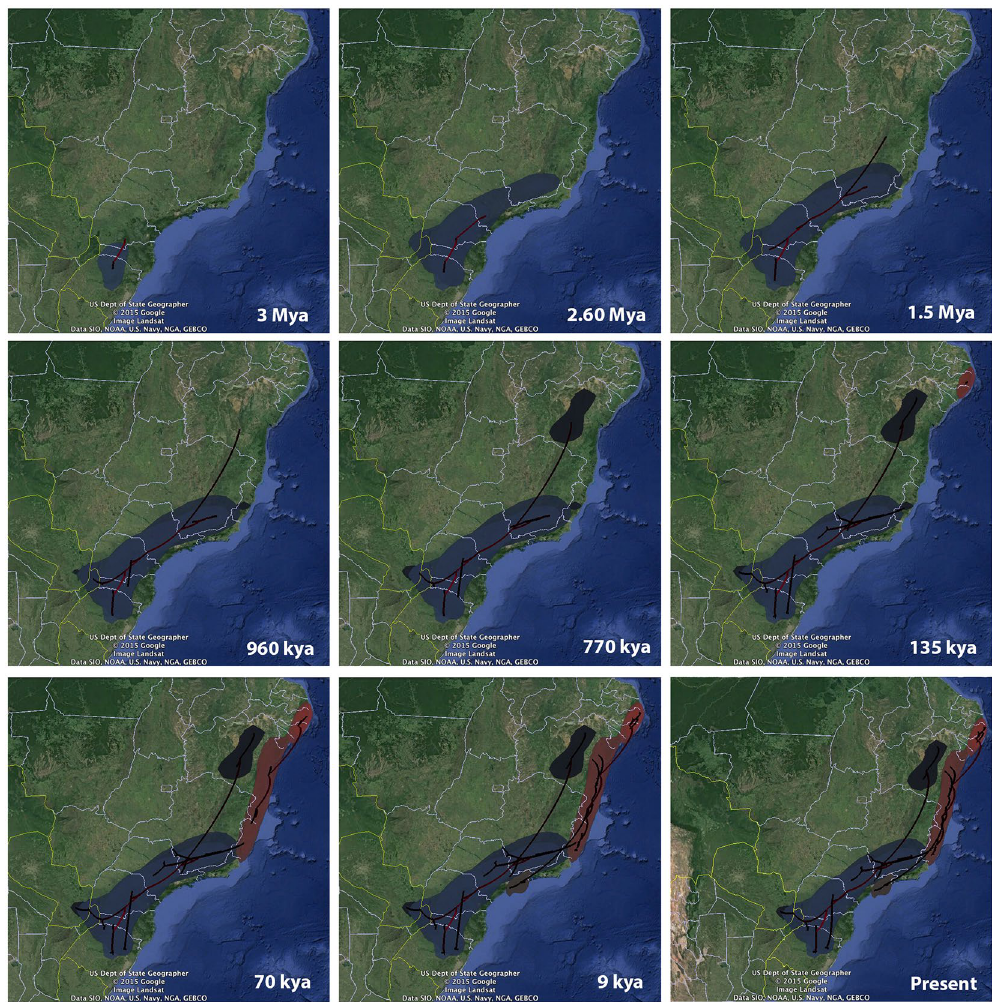
Figure 5. Bayesian reconstruction of the spatio-temporal dispersal of S. cyanea (blue shading) and S . aff. septentrionalis (red shading). Reconstructions are based on the maximum clade credibility tree estimated with a time-heterogeneous Relaxed Random Walk (RRW) model. Shading represents 80% HPD uncertainty in the location of ancestral branches with lighter and darker shades representing older and younger dispersal events, respectively. The map was generated using the software Google Earth 7.1.5.1557 (Google Inc. 2015) (https://